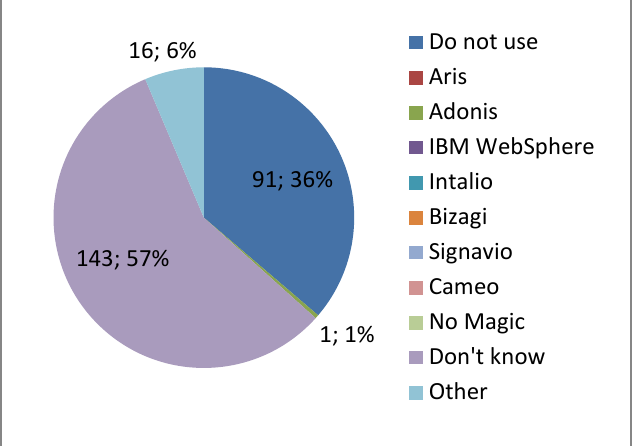
Fig. 2. The experience in the use of BP modeling tools.